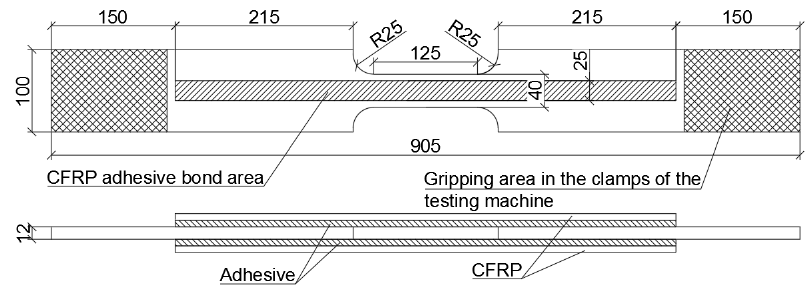
Figure 3. Tested specimens made of CFRP.